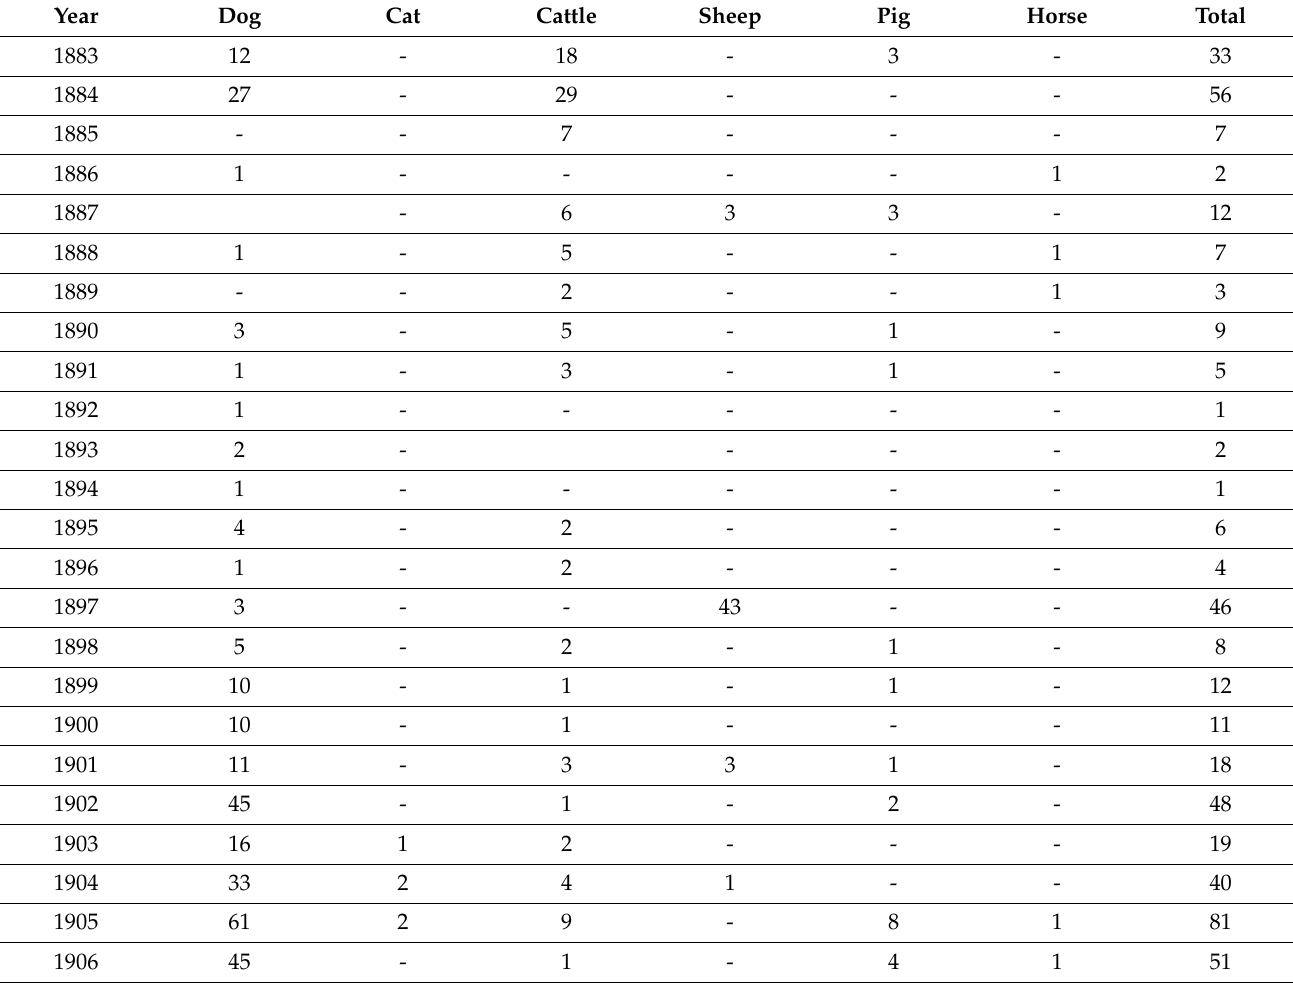
Table 1. The first systematic record of rabies in domestic animals in Serbia (1883 to 1914) (from